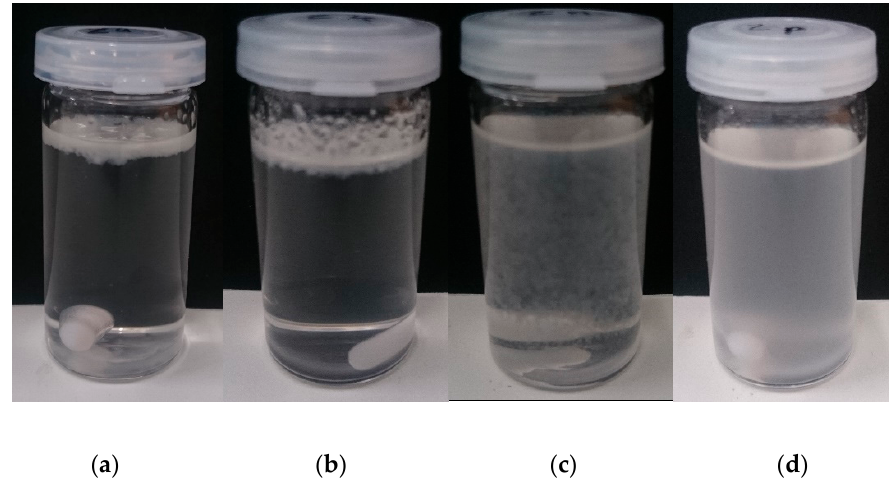
Figure 4. Samples dissolved in dichloromethane (DCM) directly after stirring. ( a ) PLA / EPDM / SBO, ( b ) PLA / EPDM / SBO / TBEC, ( c ) PLA / EPDM / SBO / EMAGMA, and ( d ) PLA / EPDM / SBO / EMAGMA /